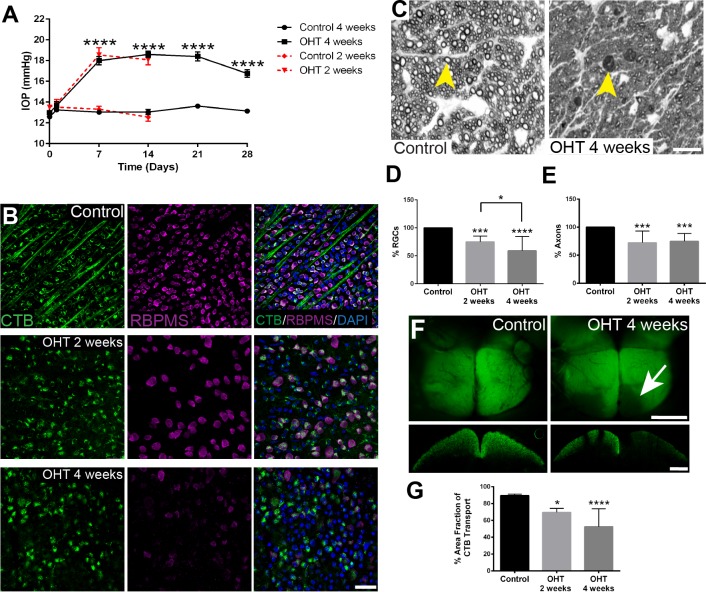
Degeneration of RGC somata and axons and impaired anterograde transport after 2 and 4 weeks of OHT. (A) Significant IOP elevation was observed after 2 (control [Ctrl]: n = 16, OHT: n = 17) and 4 weeks (Ctrl: n = 29, OHT: n = 54) of OHT versus control. IOP elevation was significantly higher than baseline from day 7 through 28 (****P < 0.0001). An average of 10 IOP measurements were taken per eye, per time point. (B) Immunofluorescence of RGCs (RBPMS, magenta) in whole-mount OHT (2 and 4 weeks) compared with control retinas. RGCs also are labeled with CTB (green). Scale bar: 20 μm. (C) ON cross sections with an arrowhead pointing to a healthy axon (right) in a control ON; in the ON taken from a mouse with OHT (left), the arrowhead points to a degenerating axon. Scale bar: 50 μm. (D) RBPMS-positive RGC somata in whole-mount retinas were quantified 14 and 28 days after OHT using unbiased stereology. There were significantly fewer (F2,53 = 29.76, ****P < 0.0001) RGCs after 2 weeks (n = 11) and after 4 weeks (n = 25) of OHT compared with control retina (n = 20). Tukey's post hoc test showed a significant decrease in RGCs after 2 (**P < 0.01) and 4 (****P < 0.0001) weeks of OHT compared with control, and after 4 weeks of OHT compared with 2 weeks (*P < 0.05). RGC density in Control = 4143 ± 224.6; after 2 weeks of OHT = 3526 ± 147.2; and after 4 weeks of OHT = 1925 ± 167. (E) Significant axon loss at 2 weeks (n = 9) and 4 weeks (n = 12) after OHT (F2,30 = 13.96, ***P < 0.001) was observed in ONs compared with control (n = 12). Tukey's post hoc test showed significant axon loss (***P < 0.001) after 2 weeks and 4 weeks of OHT compared with control. No significant difference in axon loss was observed between 2 and 4 weeks after OHT. Axon number in Control = 48,040 ± 3766; after 2 weeks of OHT = 31,062 ± 4180; and after 4 weeks of OHT = 24,253 ± 2269. (F) Dorsal views (Scale bar: 1000 μm) and coronal sections (Scale bar: 500 μm) of the SC show significant anterograde axonal transport deficit. Arrow shows lack of CTB label (green) in the lower left quadrant of each lobe compared with the control. (G) Percent area fraction of CTB in the SC of OHT mice was significantly lower (F2,27 = 17.35, ****P < 0.0001) at 2 weeks (n = 8) and 4 weeks (n = 10) after OHT compared with control (n = 12). Tukey's post hoc test showed a significant decrease in percent area fraction of CTB between 2 (*P < 0.05) and 4 (****P < 0.0001) weeks after OHT compared with control. No significant difference in percent area fraction was observed between 2 weeks and 4 weeks after OHT.